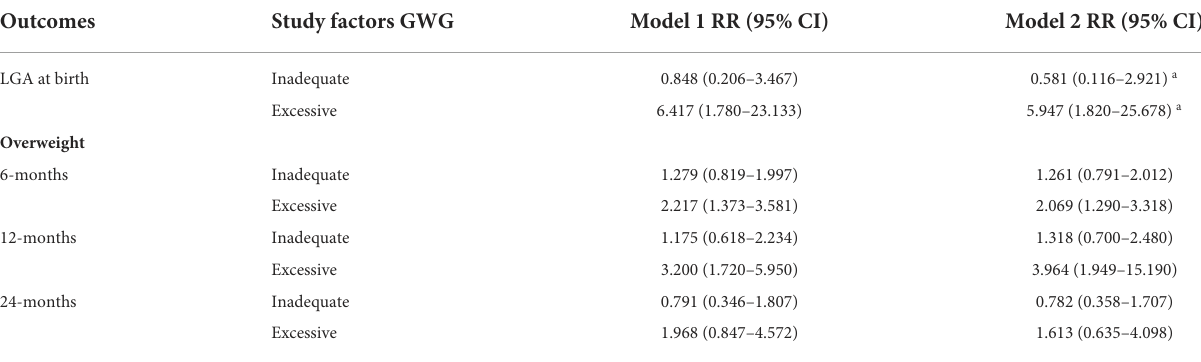
TABLE 3 Unadjusted and adjusted correlations between total gestational weight gain and LGA and age-specific